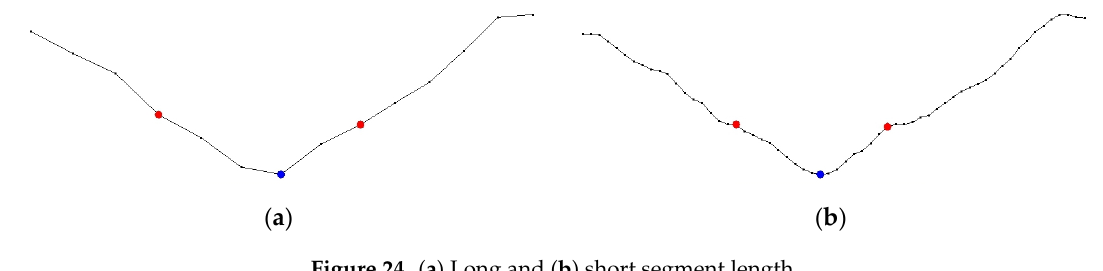
Figure 24. ( a ) Long and ( b ) short segment length.